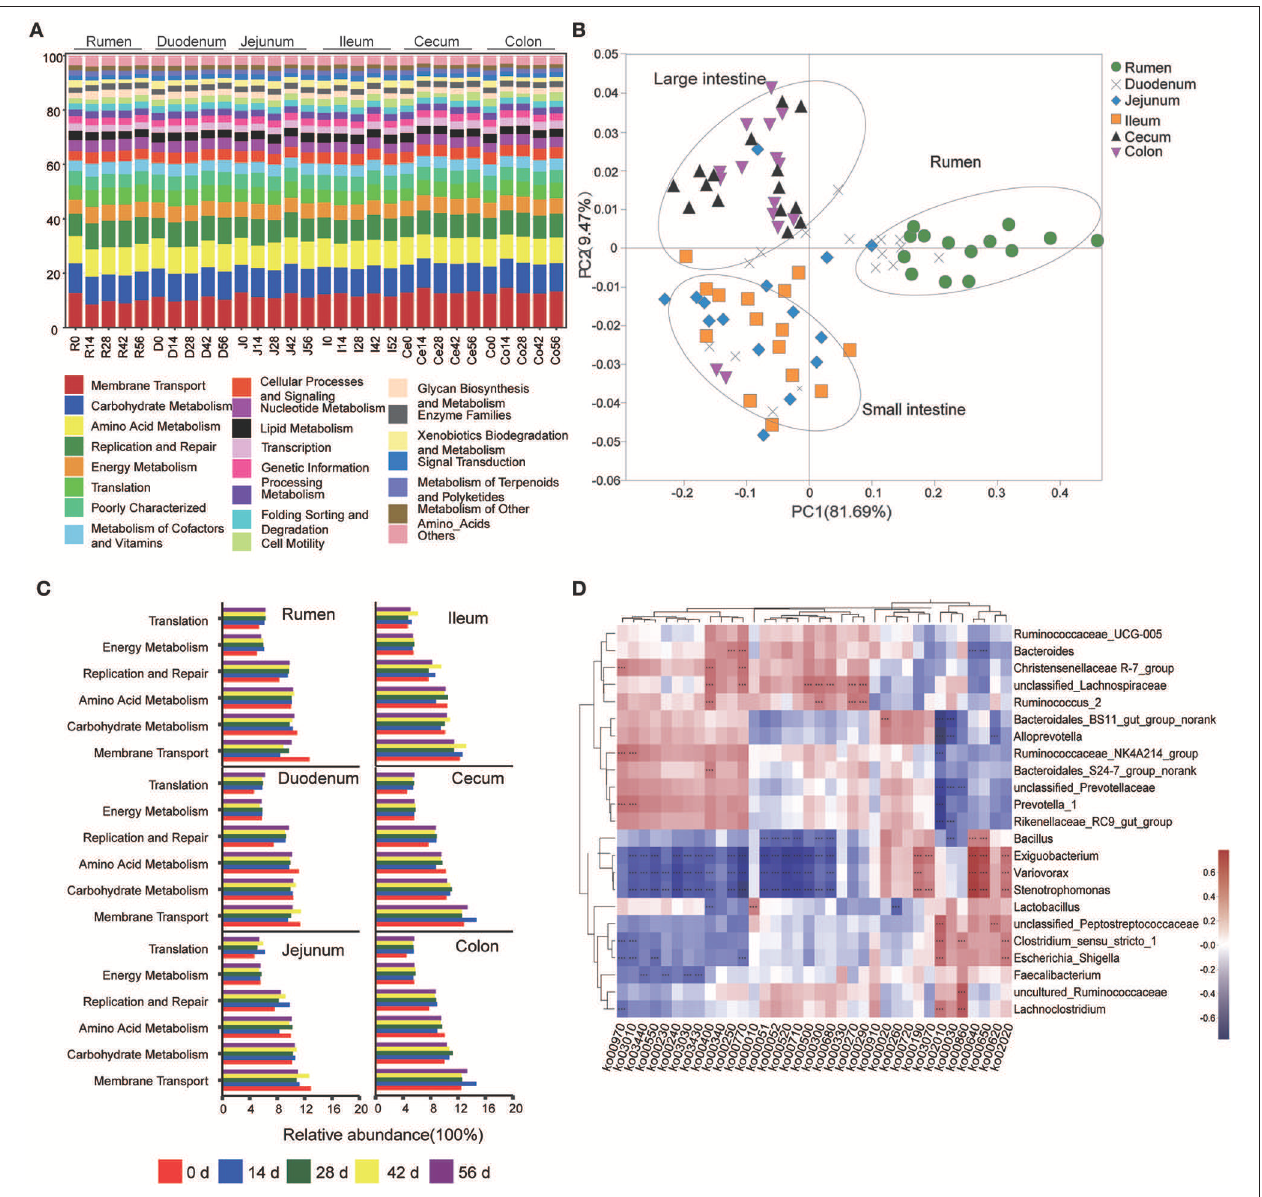
FIGURE 5 | Metagenomic functional predictions. (A) Variations in KEGG metabolic pathways of microbiota at different ages throughout the gastrointestinal tract (GIT) region of kids. (B) PCoA profile of microbial functional KEGG pathways using Bray-Curtis dissimilarity metric according to the abundance of metabolic pathways. (C) Comparison of the predominant KEGG metabolic pathways in each age group. (D) Interaction heatmap between the predominant common bacterial genera and potential functional KEGG pathways (at the KEEG level 3); *0.01 < P < 0.05; **0.001 < P < 0.01; *** P <